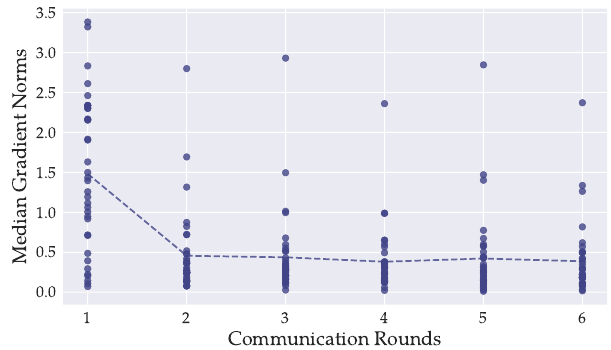
Figure 4. For each model layer of the DenseNet121, we tracked the median (cid:96) 2 -norms during training of every local model. Each dot represents the mean of one layer-median over all local models. The dashed line depicts the overall mean of all per-layer (cid:96) 2 -norm medians. Most layers’ (cid:96) 2 -norms were greater during the first round of training than in later stages. In our experiments, image reconstruction was better on models from later rounds, suggesting that the magnitude of gradient (cid:96) 2 -norms is not a primary indicator for attack success.